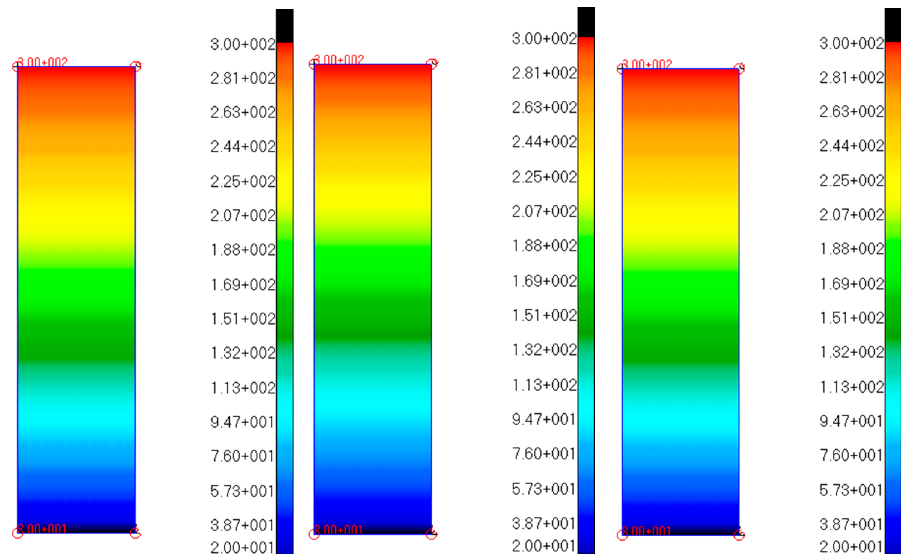
Figure 4. The comparison between real temperature distribution, initial temperature distribution and updated temperature distribution. Table 6. The comparison among real temperature, initial temperature and updated temperature.